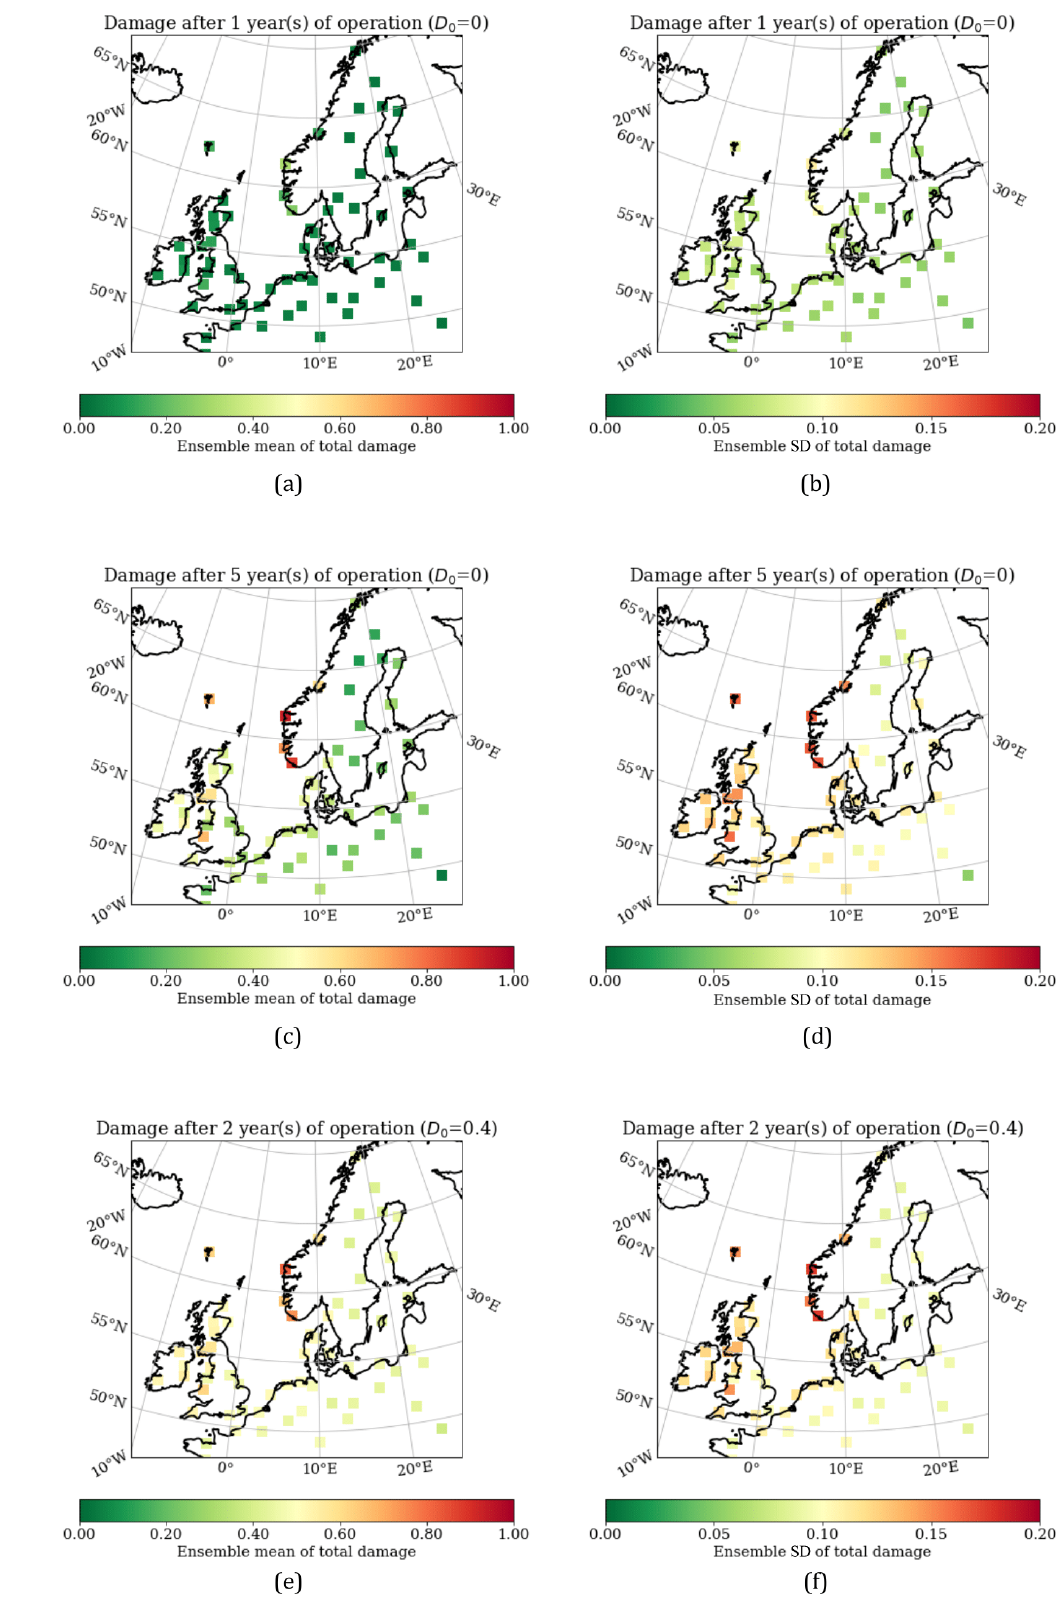
Figure 15. Erosion maps created for three different scenarios to demonstrate the versatile capabilities of the developed prediction tool. Panels (a, c, e) visualize ensemble means, and panels (b, d, f) visualize ensemble standard deviations for the three cases. Wind Energ. Sci., 8, 173–191,